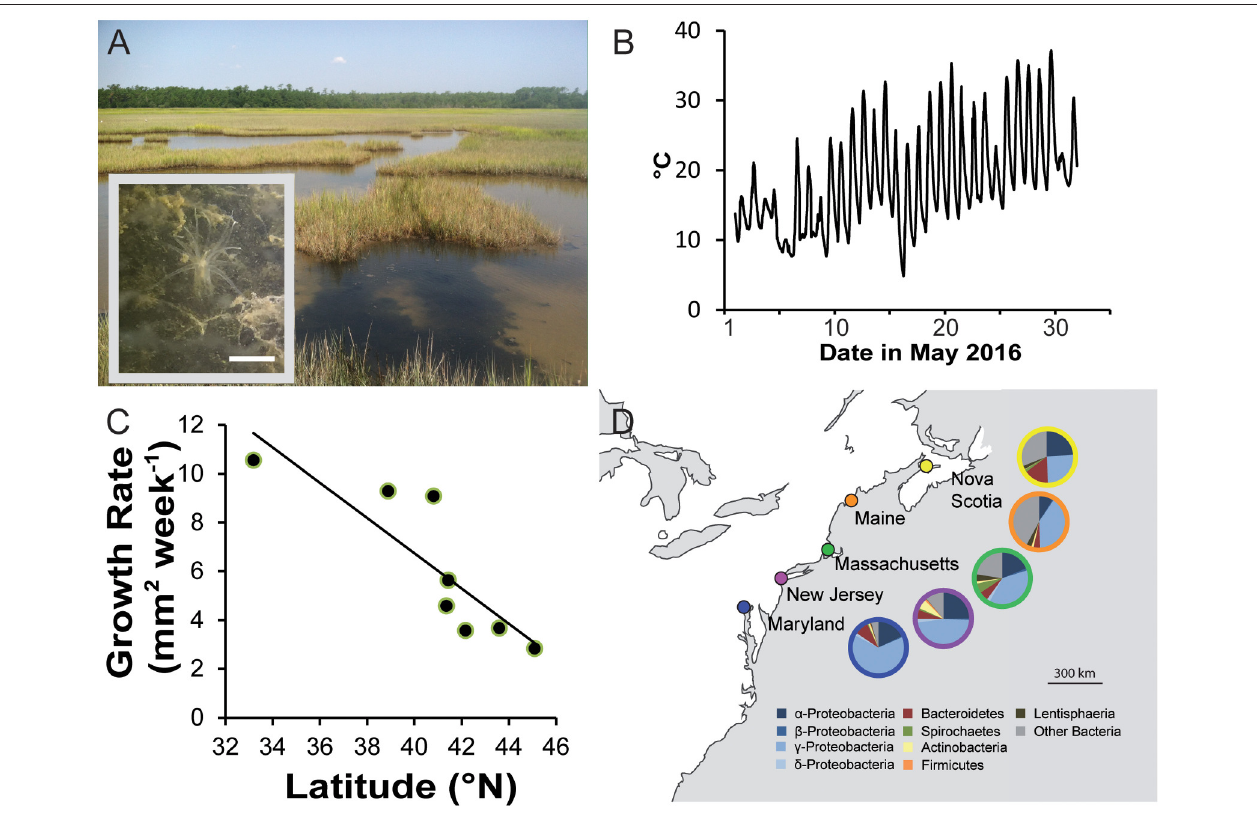
FIGURE 2 | (A) Natural habitat of N. vectensis along the Nonesuch River, Maine, USA; small insert: single polyp of N. vectensis burrowed in the sediment. (B) Temperature data (May 2016) collected by a temperature logger positioned in a pool occupied by N. vectensis in Sippewissett Marsh, Massachusetts, USA. (C) Relationship of growth rate and latitude of origin for individuals cultured at 29 ◦ C (data from Reitzel et al., 2013a). (D) Contribution of host biogeography to the overall pattern of bacterial diversity between individual Nematostella polyps sampled from the US east coast. Map showing the location of the sampled populations: Pie charts representing the mean relative abundances of bacterial classes at the five different populations (data from Mortzfeld et al.,